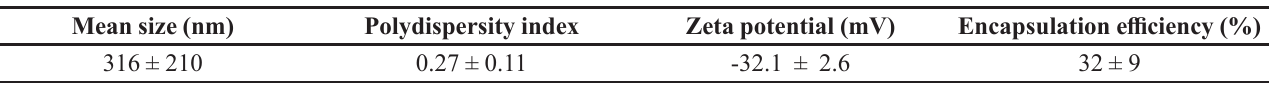
TABLE I - Mean diameter, polydispersity index, zeta potential and encapsulation efficiency of BSA nanoparticles containing rutin Mean size